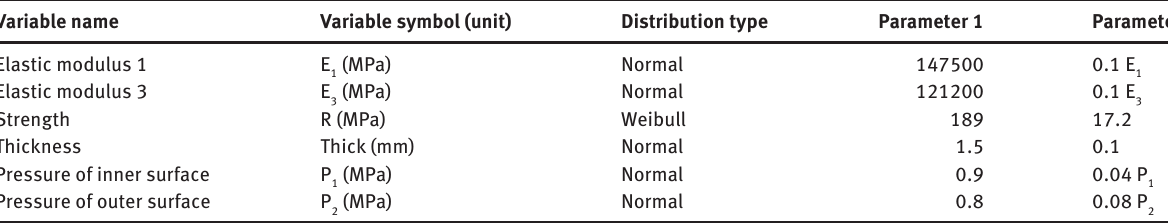
Table 2 Random variables and their distribution.